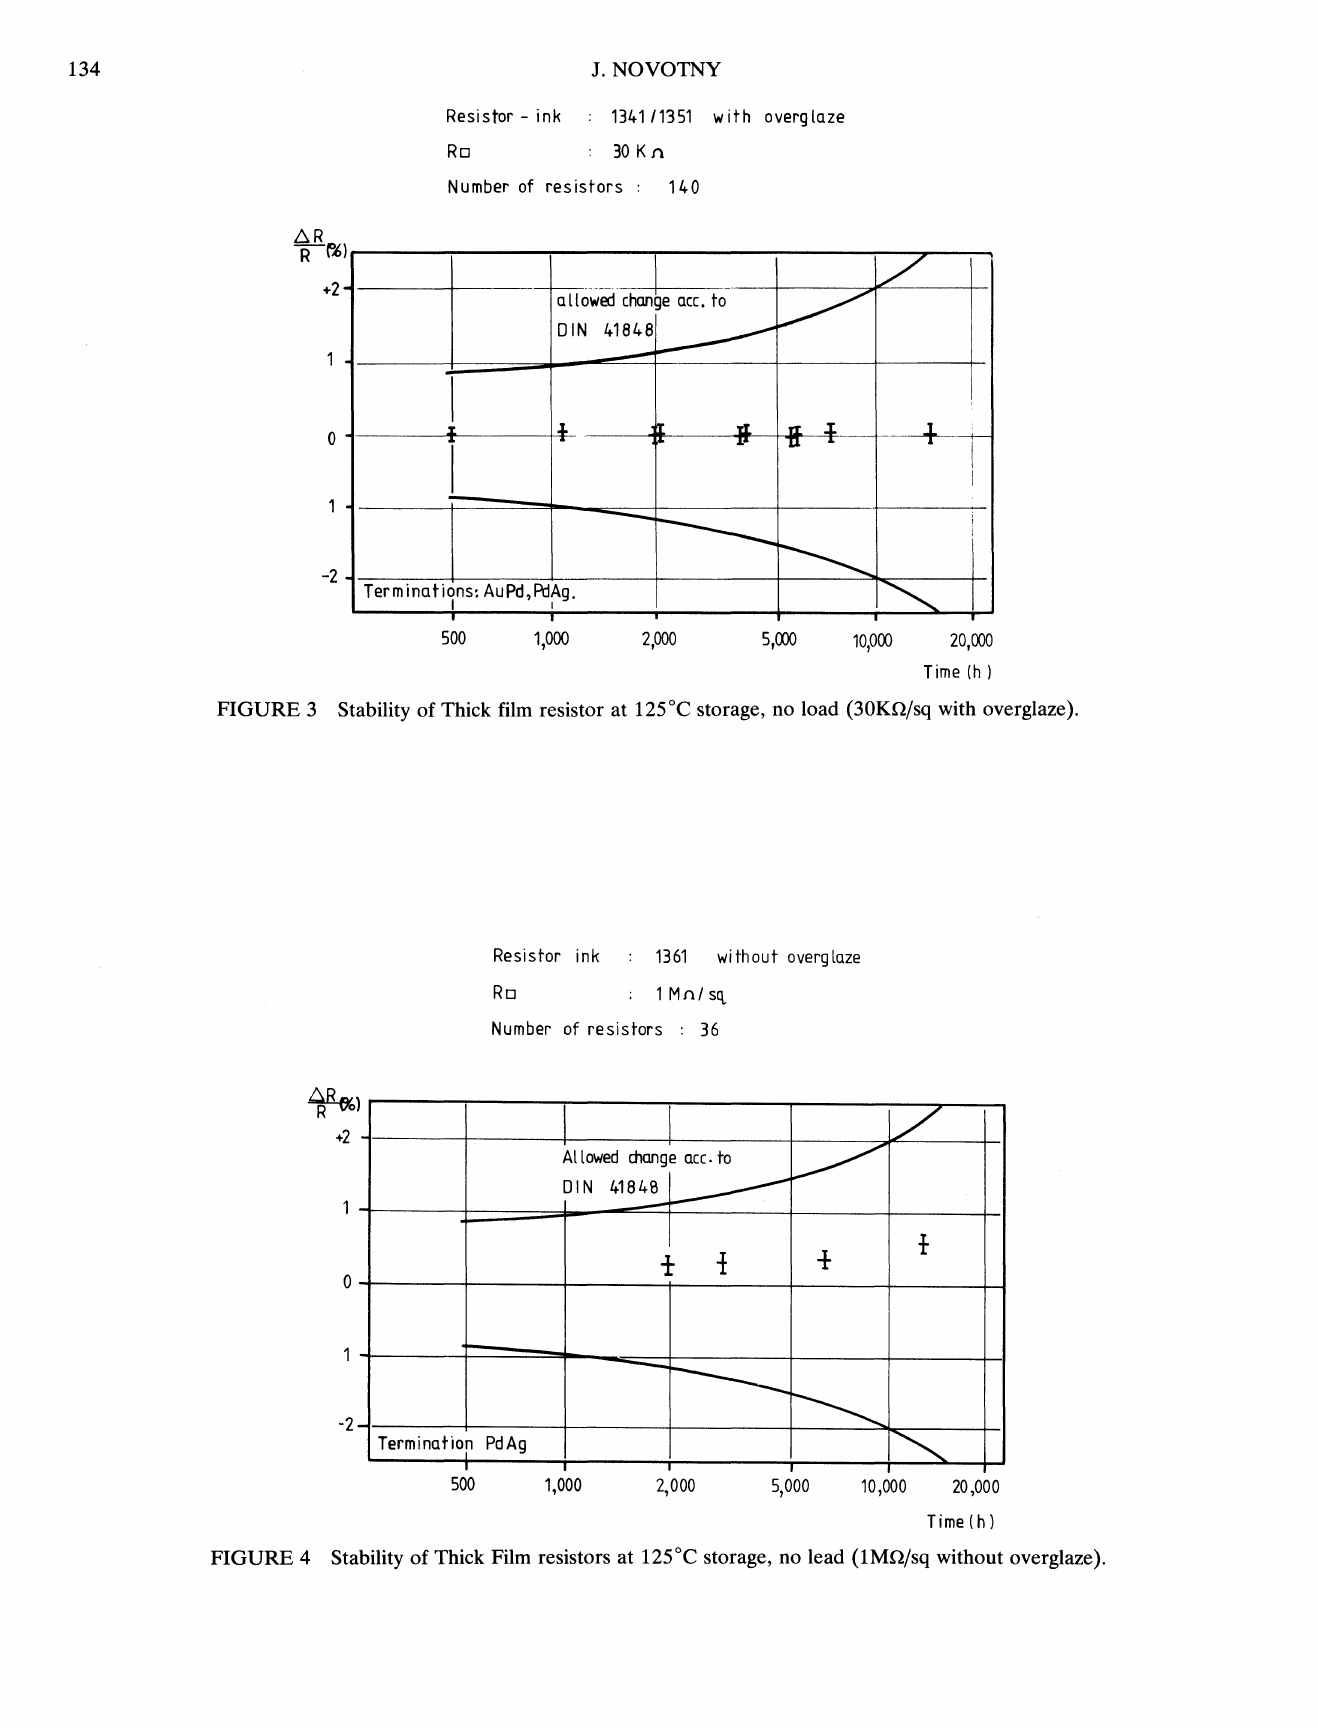
FIGURE 4 Stability of Thick Film resistors at 125C storage, no lead (1MD/sq without